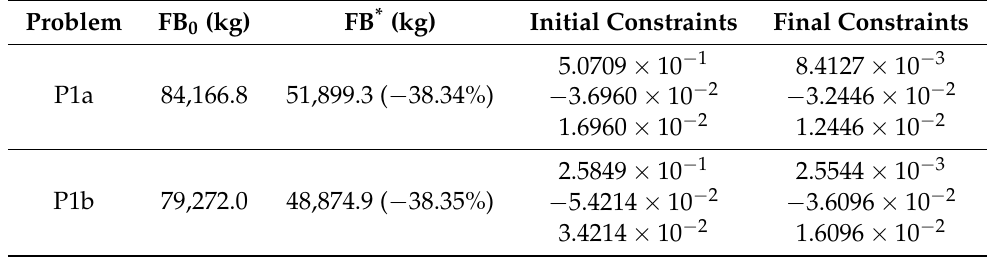
Table 7. Summary of rigid optimization cases (subscript “0” and superscript “*” denote initial and final designs.)